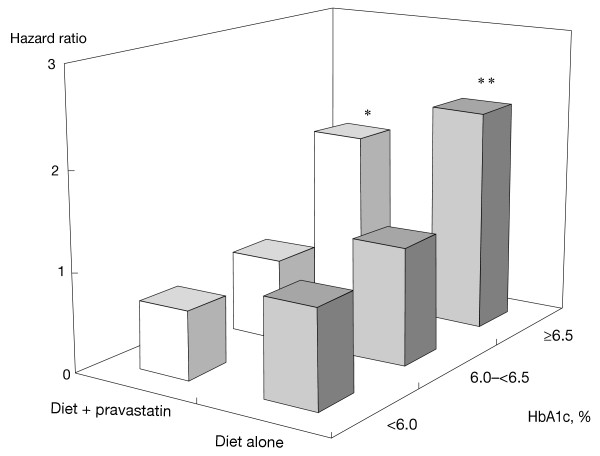
Relation between HbA1c and CVD according to treatment arms. P-values were calculated against <6.0% in each group by Cox proportional hazard model adjusted for sex, age, baseline LDL-C, baseline HDL-C, hypertension, chronic kidney disease (estimated glomerular filtration rate <60), and smoking. *p <0.05; **p <0.01.